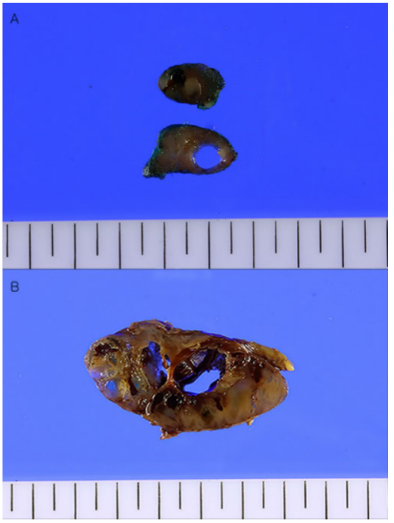
Figure 3. Gross findings of cervical lymph nodes ( A ) and right thyroid gland ( B ). ( A ) The cervical lymph node is enlarged 2.5 cm in maximum length. The cut surface of the lymph node shows a pale tan to brown solid appearance with cystic change. ( B ) The thyroid gland shows multiple variable-sized pale tan to brown solid and cystic nodules. In the areas of the superior thyroid artery and sternothyroid as well as enlarged cervical lymph nodes, benign thyroid tissues showed nodular proliferation with cystic changes. Some enlarged lymph nodes occupied almost the entire area (Figure 4A,B). Both thyroid lobes also had multiple follicular nodules covering almost all areas. Although follicular nuclei showed little irregularity in the nodular hyperplasia of the thyroid gland, atypical malignant cytologic features such as intranuclear grooves, pseudo-inclusions, and ground-glass appearances of nuclei were not observed (Figure 4C), except for an occult papillary microcarcinoma of a follicular variant (0.2 cm in diameter) in the remnant left thyroid (Figure 4E). The occult thyroid microcarcinoma was shown to be positive in the immunohistochemical staining for HBME-1, Galectin-3, and Cytokeratin 19. Among them, HBME-1 showed strong positivity (Figure 4F) compared to the surrounding benign thyroid tissue and nodular hyperplasia (Figure 4D).